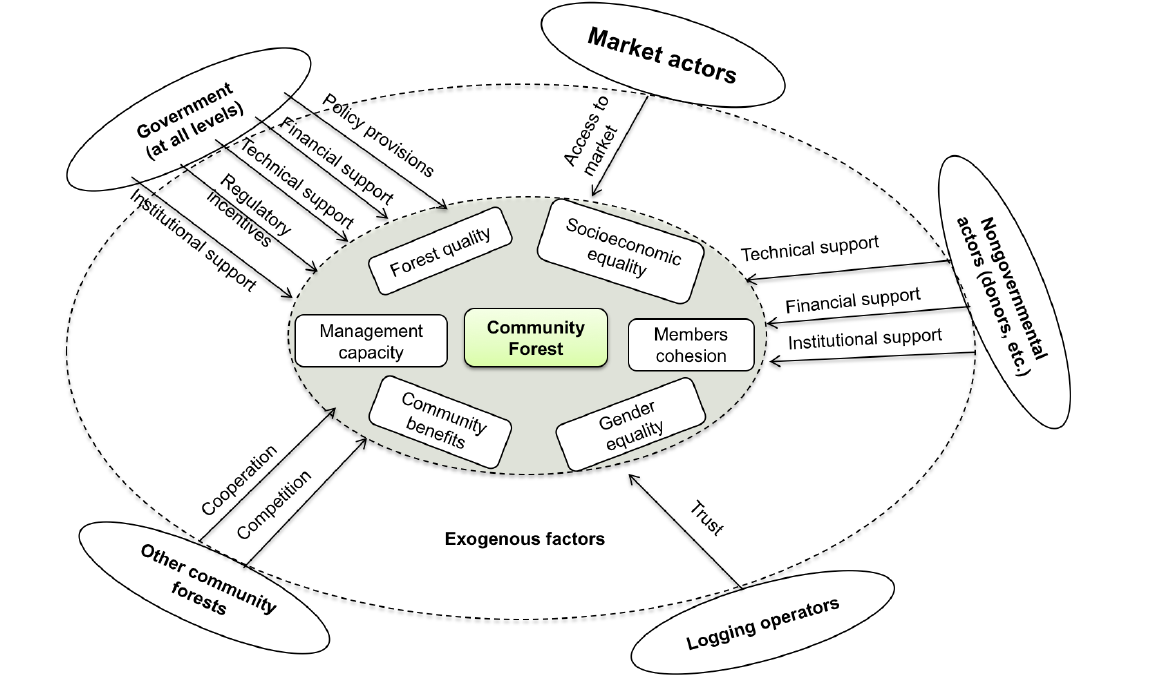
Fig. 1 . Combinations of internal and external factors influencing community forest (CFs) performance. Note: The shaded core zone refers to the internal factors and the placement of the arrows does not have any relation with the internal factors the arrow is close to.